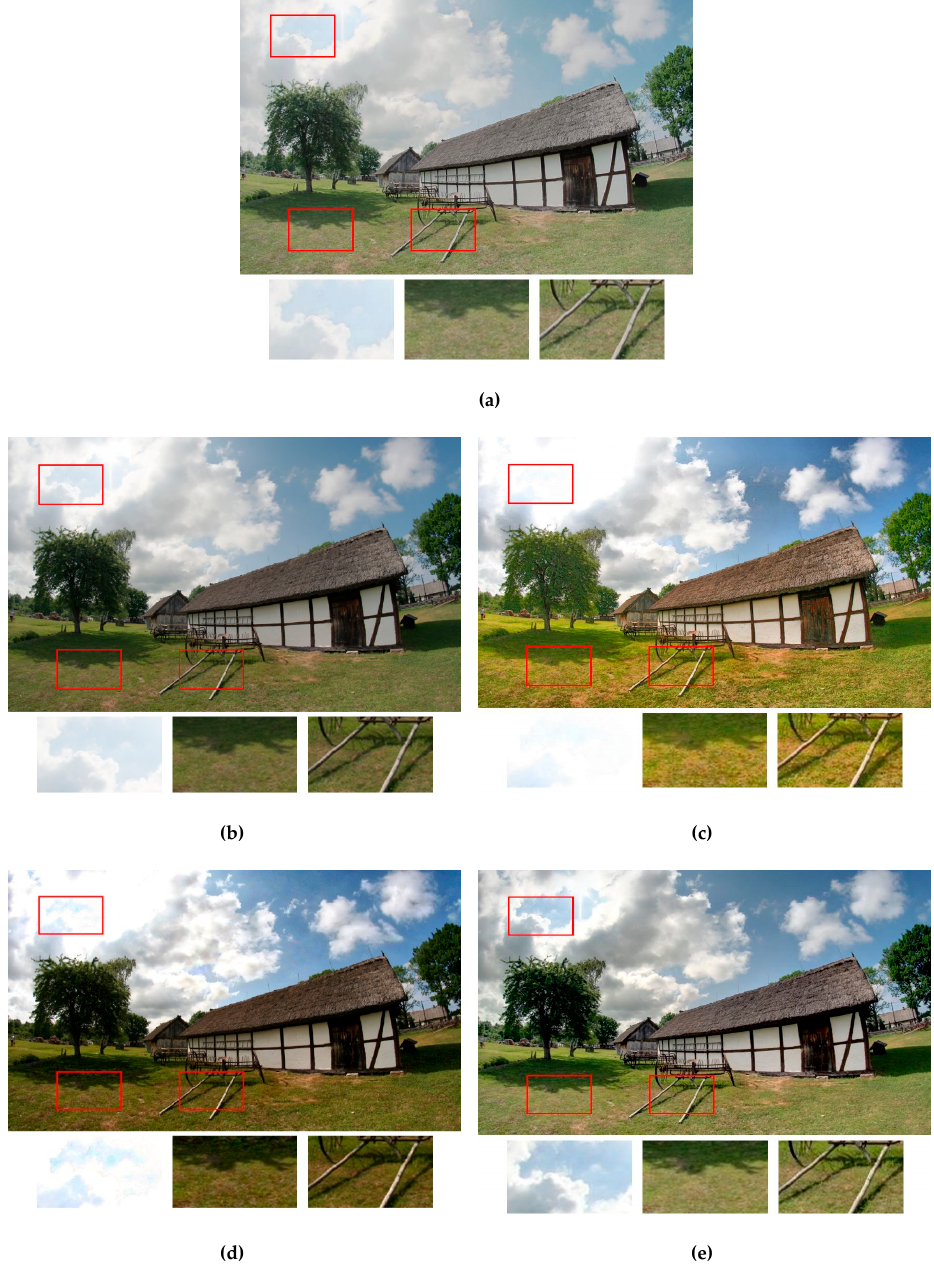
Figure 5. Visual comparison of the exposure fusion results using the test image Cottage. ( a ) Results from using the method in Reference [5]. ( b ) Results from using the method in Reference [6]. ( c ) Results from using the method in Reference [28]. ( d ) Results from using the method in Reference [23]. ( e ) Results from the proposed method. The enlarged versions of the red rectangles are provided to illustrate the subtle differences.